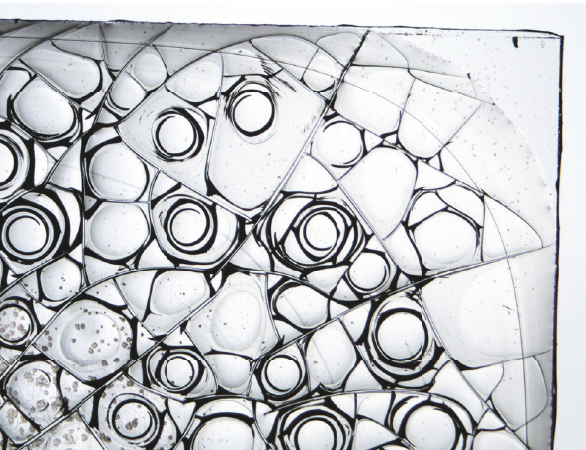
Figure 11: Crack patterns in a dried sample of albumin (courtesy of N.A.